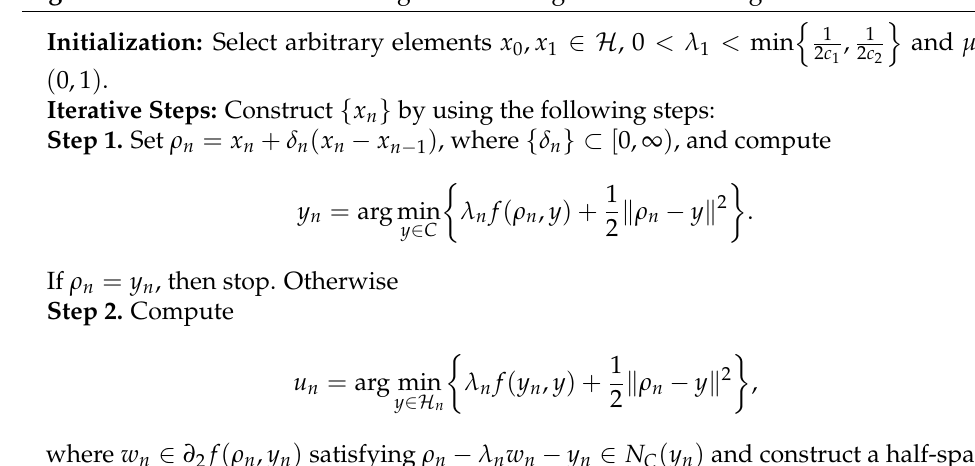
Algorithm 2 Modified inertial subgradient extragradient Mann Algorithm 2